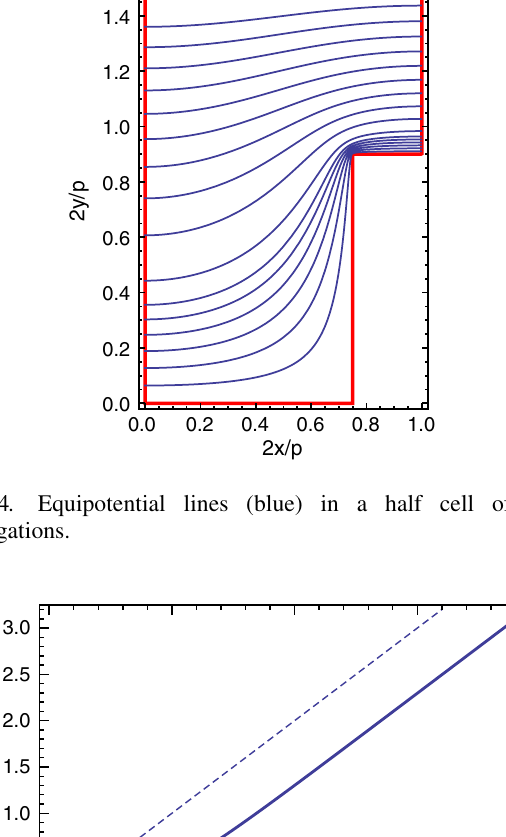
FIG. 5. Dimensionless potential line). The broken line is the two lines for large values of (cid:1) y is equal to Eq. (9) are shown in Fig. 4 and the dependence